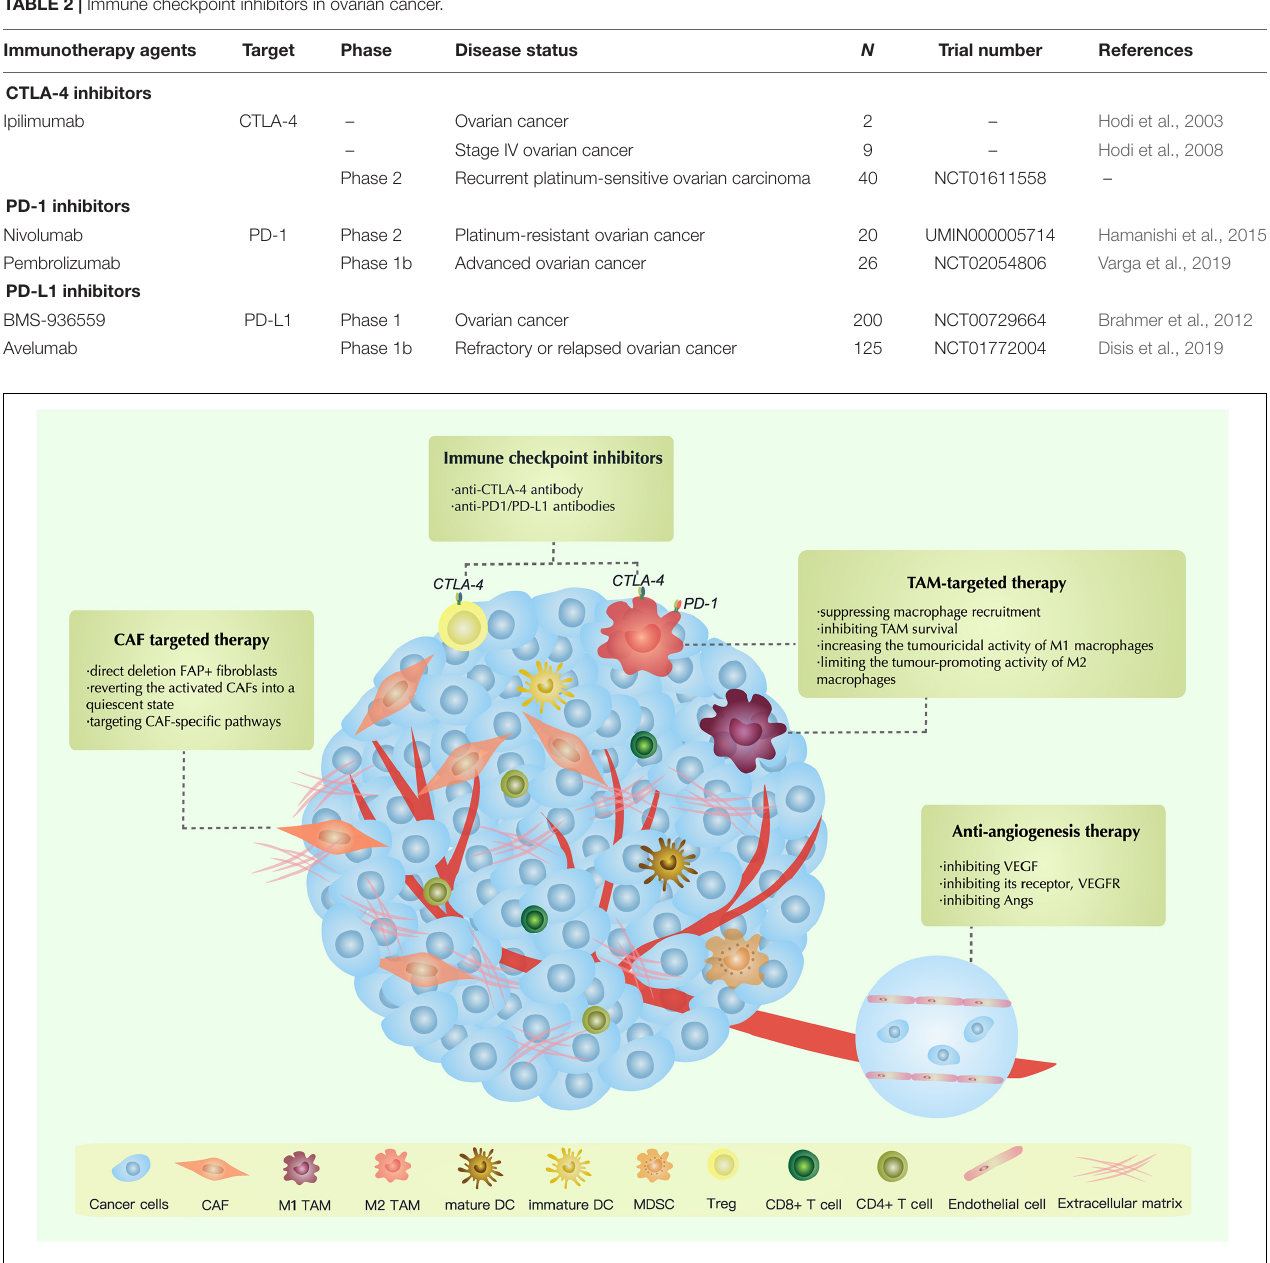
FIGURE 3 | Tumor microenvironment related therapeutic strategies in ovarian cancer. The graph shows multiple strategies targeted the tumor microenvironment in ovarian cancer. Among them, several strategies are currently in clinical use, while others are at different phases of clinical development. CAFs: Cancer-associated fibroblasts; TGF- β : Transforming growth factor- β ; TAMs: Tumor-associated macrophages; CCL2: chemokine (C-C motif) ligand 2; CSF-1R: colony stimulating factor-1 (CSF1) receptor; VEGF: Vascular endothelial growth factors; VEGFR: Vascular endothelial growth factor